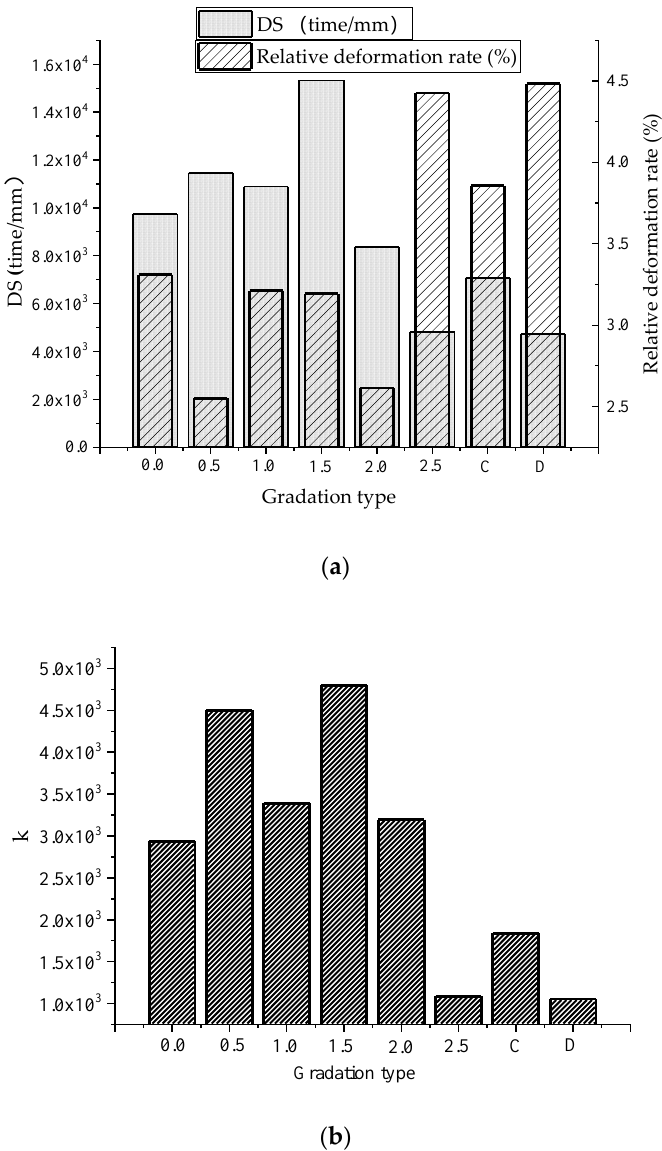
Figure 7. High-temperature test results for different mixture types. ( a ) Dynamic stability (DS) and relative deformation rate; ( b ) K .